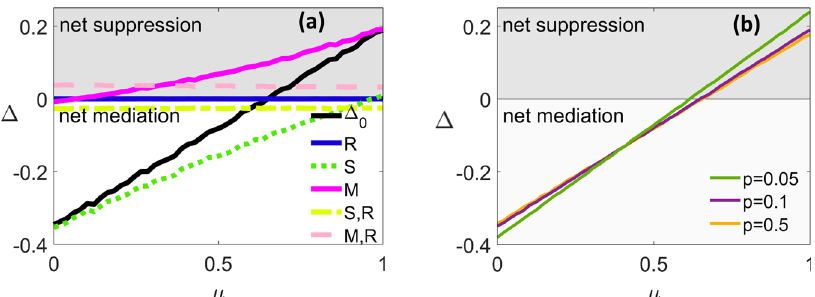
Fig. 3 Interpolating model. a Values of Jaccard net difference Δ (see the text), obtained averaging 50 realisations of an interpolating model giving a blend of mediation and suppression (see the text), where each network has N = 300 nodes and varying model parameter p , as a function of the interpolation parameter μ (in each of the N ( N − 1) steps we apply Algorithm 2 with probability 1 − μ and Algorithm 3 with μ ). b Revised version of the left panel, this time selectively removing all suppression and mediation effects according to our theoretical framework. The original curve, for an interpolating model generating a blend of mediation and suppression, is depicted in black. The blue curve (R) is pure randomisation, which generates Δ ≈ 0. The dotted green line (S) corresponds to a selective rewiring that removes all hidden suppression: in that case, the curve is kept always below zero (increasing μ increases the amount of Algorithm 3, but then is selectively rewired, thus effectively randomising the networks and pushing Δ to zero). The pink curve (M) is the result of a selectively rewiring that removes all hidden mediation: in that case the curve is pushed to the regime Δ > 0. As μ increases, the amount of Algorithm 3 (generating suppression) is increased, hence pushing Δ to larger values. The dashed yellow (S,R) and pink (M,R) lines are the result of selectively rewiring on the randomised networks, and only highlight the residual values of suppression or mediation which occur by chance (as a fi nite-size effect) in randomised networks.